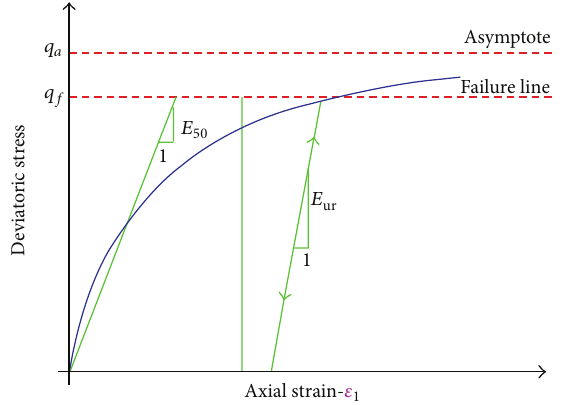
Figure 2: Hyperbolic stress-strain relation in primary loading for a standard drained triaxial